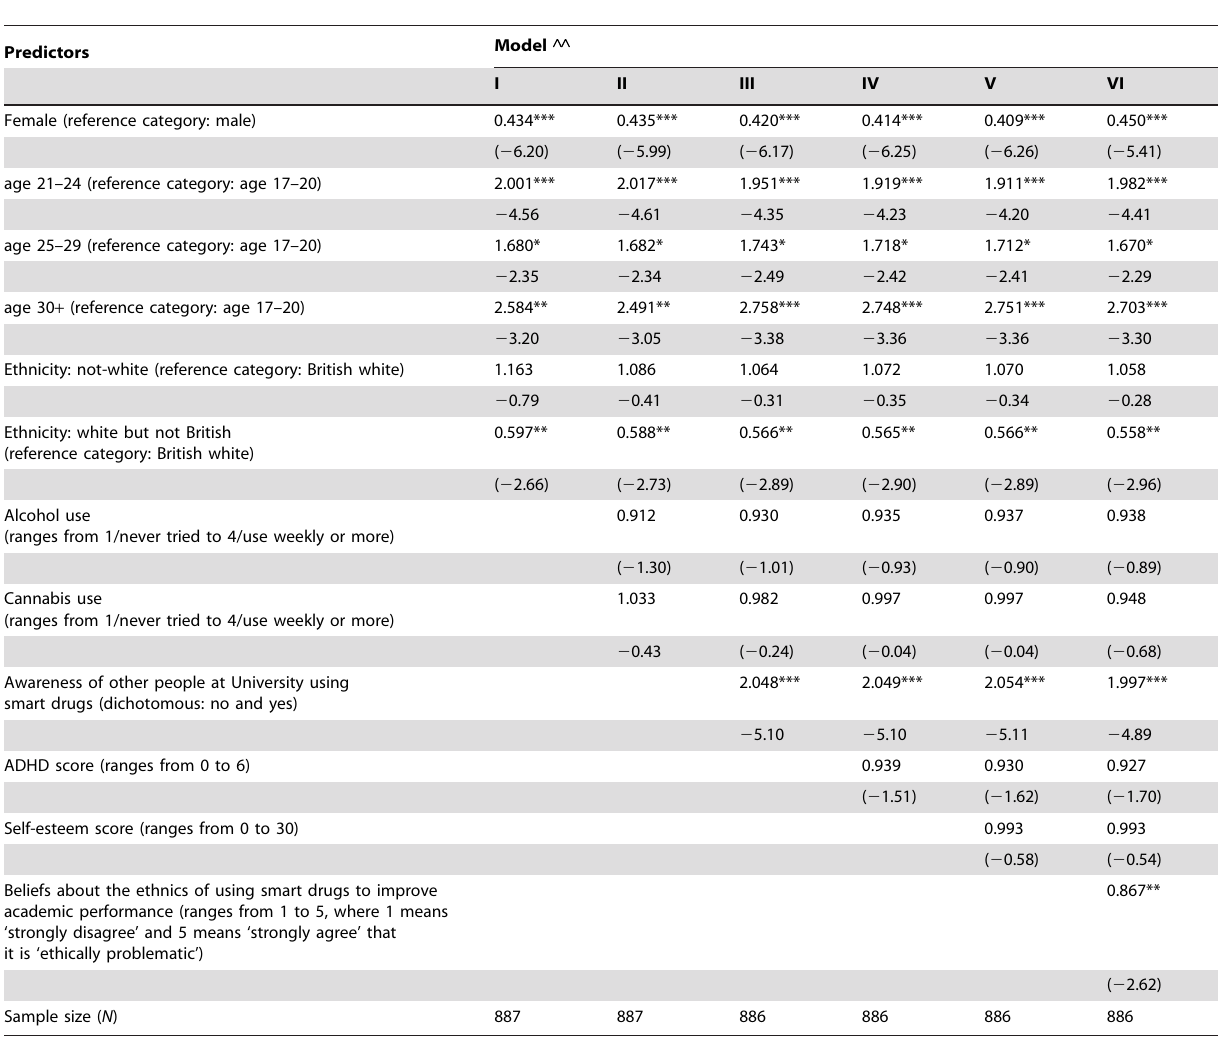
Table 10. Ordinal logistic regression predicting knowledge and use of modafinil. +